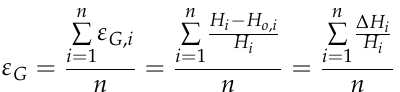
Figure 3. Effect of type of gas on bubble size distribution ( U GS = 0.01 m/s): ( a ) water; ( b ) glycerin